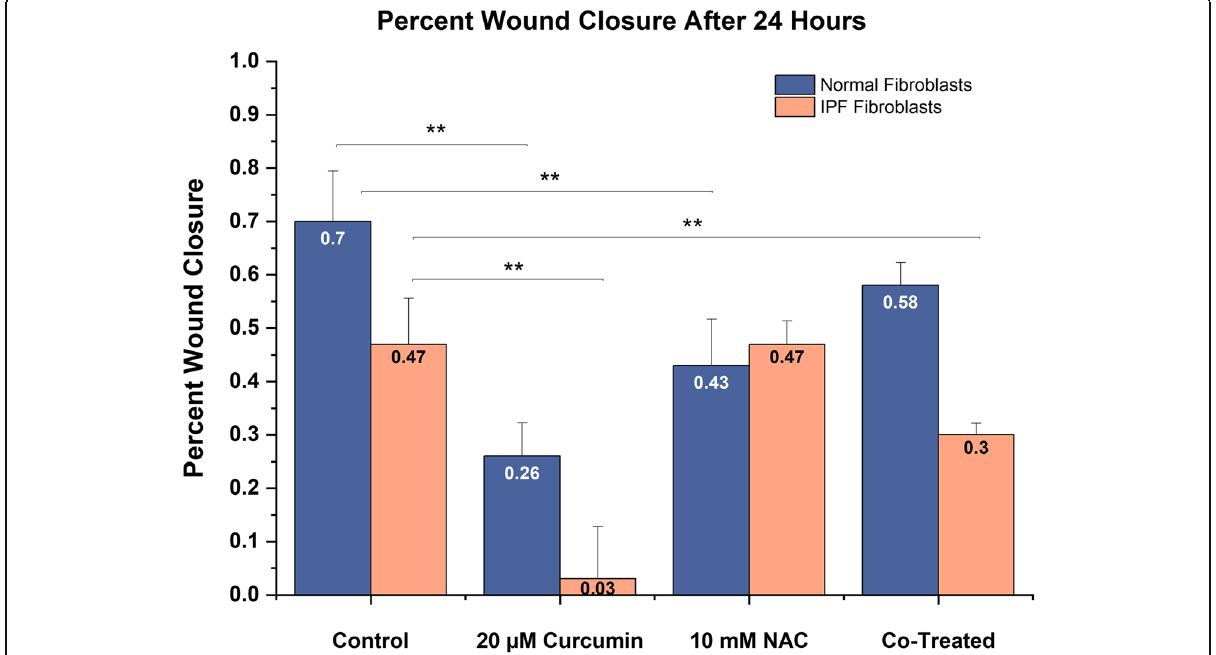
Fig. 4 Quantification of wound closure data in IPF (n = 4) and NHLF ( n = 3) after challenge: Significant reduction in 24-h wound closure rate is observed in IPF-F after 20 μ M curcumin treatment and co-treatment with NAC. This same result is observed after 20 μ M curcumin in NHLF and 10 mM NAC challenge. Co-treatment with NAC and 40 μ M curcumin does not induce a significant reduction in wound closure rate as compared to untreated control. ** indicates p value <